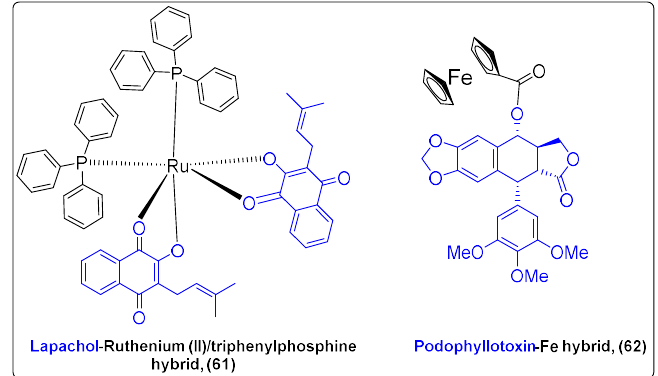
Figure 20. Natural product-based hybrids with metal complexes.